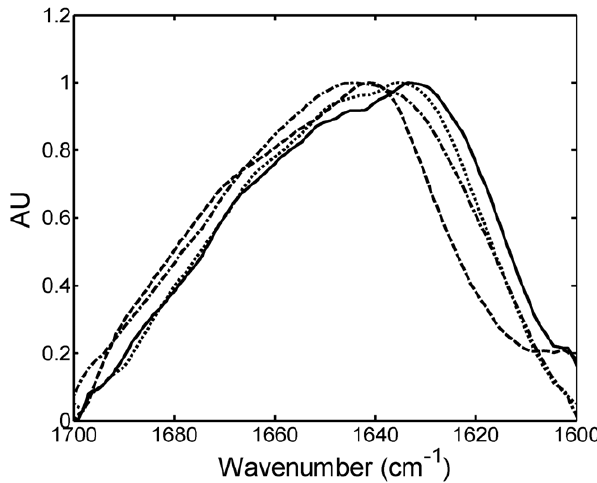
Figure 7. FTIR secondary structure analysis. Thin film ATR-FTIR spectra of native light chain dimer (–) and of light chain aggregates obtained after one month incubation in 20 mM HCl at pH 2.0 with 0.45 M NaCl (_), with 0.15 M Na 2 SO 4 (...), or with 0.49 M NaH 2 PO 4 ( { : { ) (runs 4, 8, and 6 in Table 1).